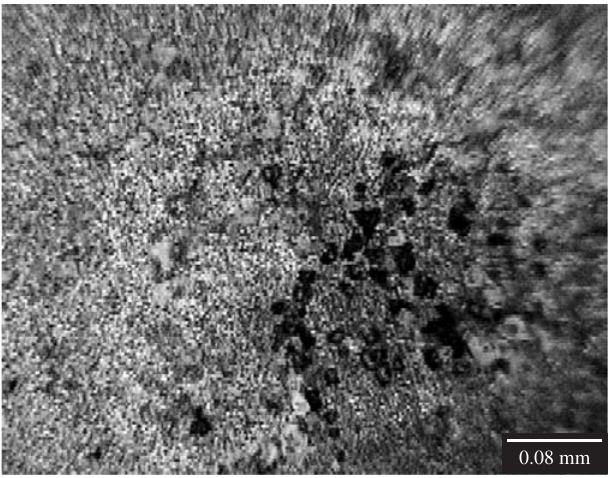
Figure 5. Microphotograph of the magnesium surface after performing the polarization curve in an 0.1%albumin-containing solution (0 X ). Localized attack with small pits can be observed.